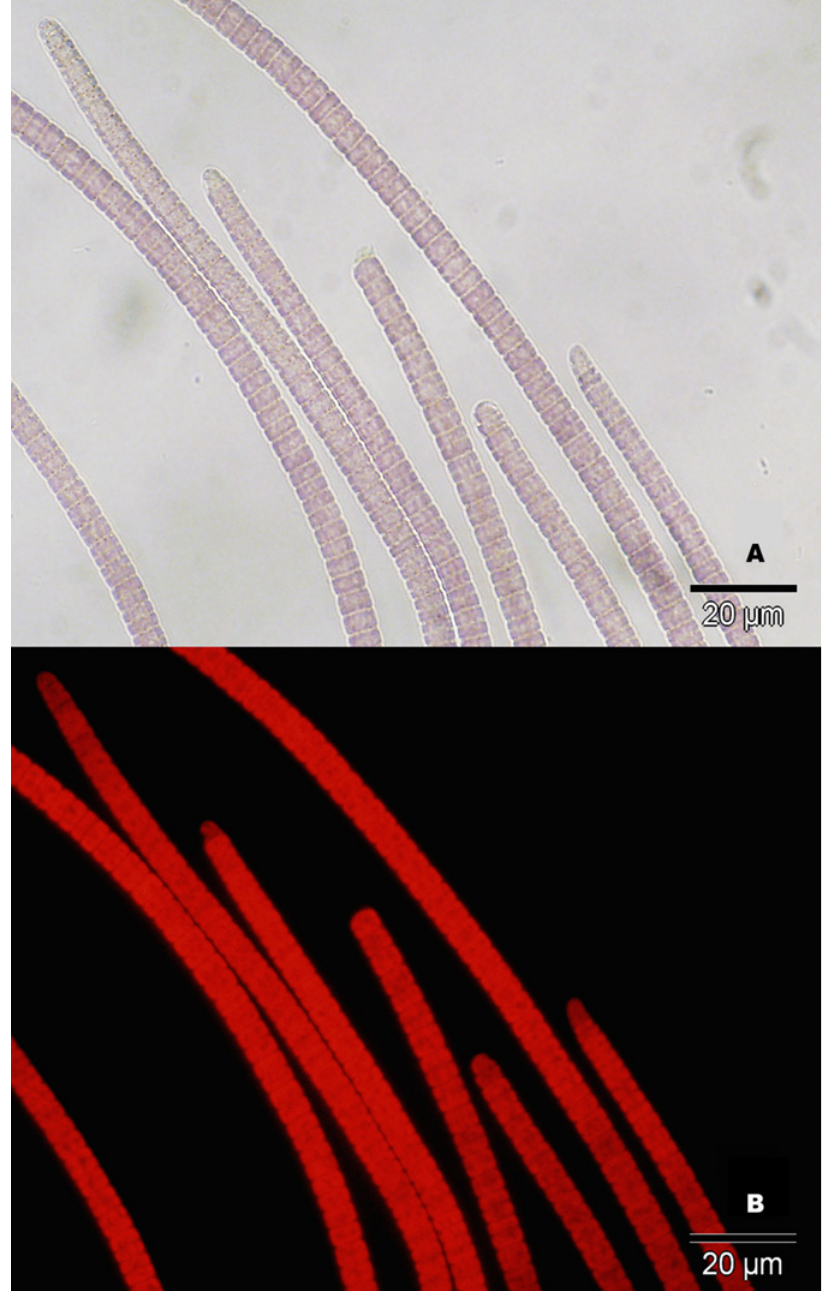
Fig 3. Microscopy images of cyanobacteria isolated from disease lesions. A) Cyanobacteria under light microscope. B) Cyanobacteria under fluorescence microscope. Red autofluorescence is indicative of photosynthetic pigments. Images were taken at 60x magnification. Black bar represents 20 μ